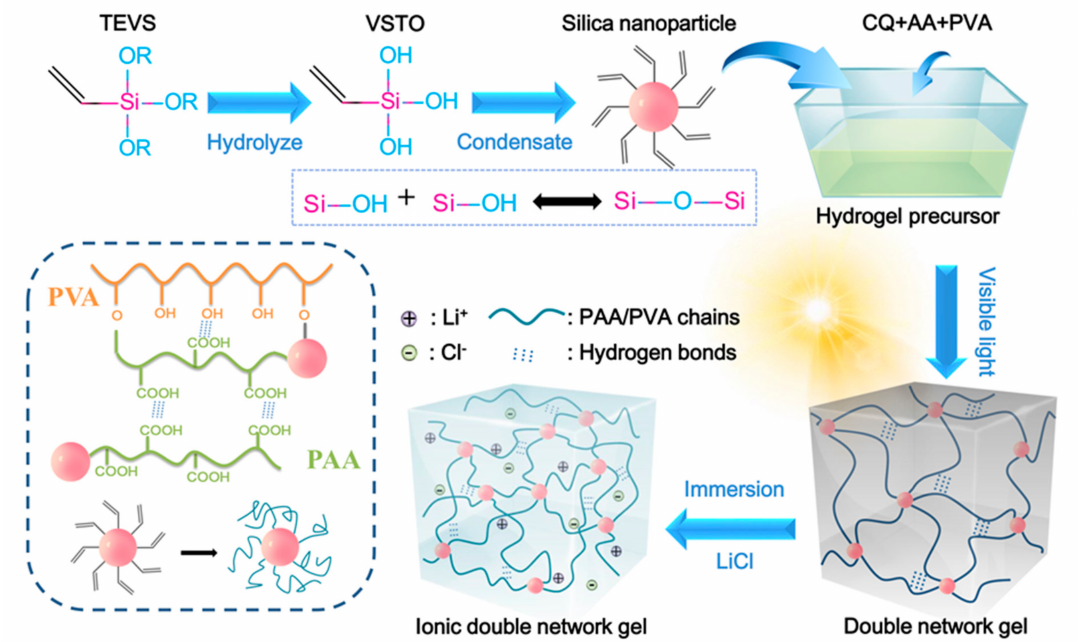
Figure 1. Schematic diagram of the preparation process and network structure of the composite double network ionic hydrogel (CDN-gel). PVA, polyviny alcohol; PAA, poly (acrylic acid); TEVS, triethoxyvinylsilane; VSTO, vinyl silanetriol; AA, acrylic acid; CQ, camphorquinone.